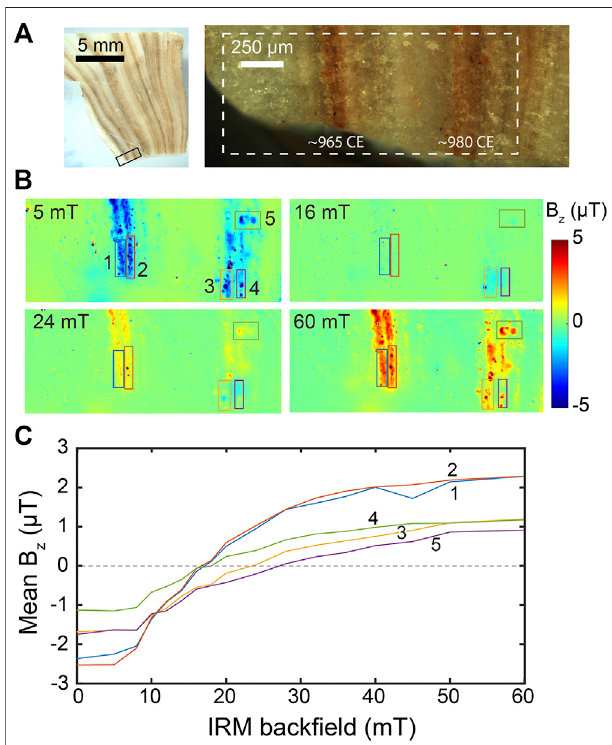
FIGURE 4 | Back fi eld IRM acquisition experiment from one fi eld of fi eld. (A) Re fl ectedlight,crossedpolarizerimagesofthemappedregion. (B) Vertical component of the magnetic fi eld after the application of a 1.5 pulse IRM into the mappingplane and anIRM ofthe indicatedstrength outoftheplane. Mapped region corresponds to white dashed box in panel (A) . (C) Back fi eld IRM acquisition curves of the fi ve rectangular regions indicated in panel (B) .